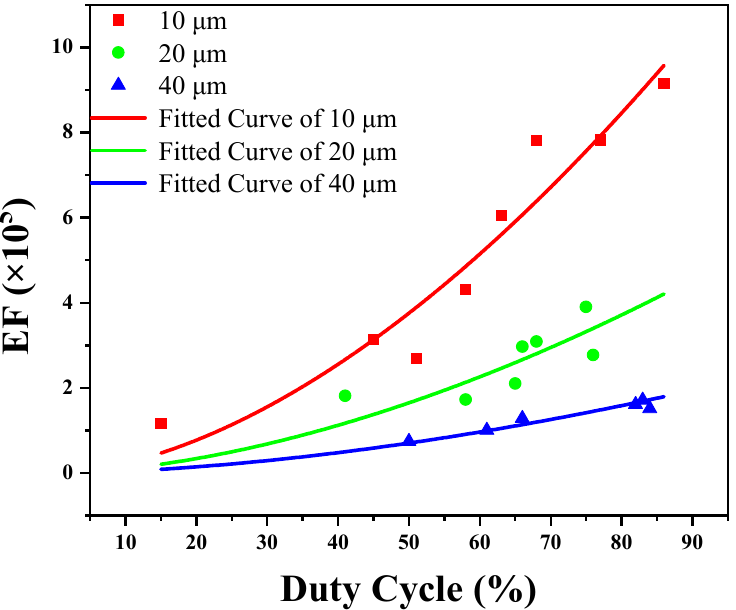
Figure 10. Calculated enhancement factor of substrate A: ■ , ● and ▲ represent the measured discrete data for 10, 20 and 40 μ m laser spots, respectively; the real line denotes the fitted curve.